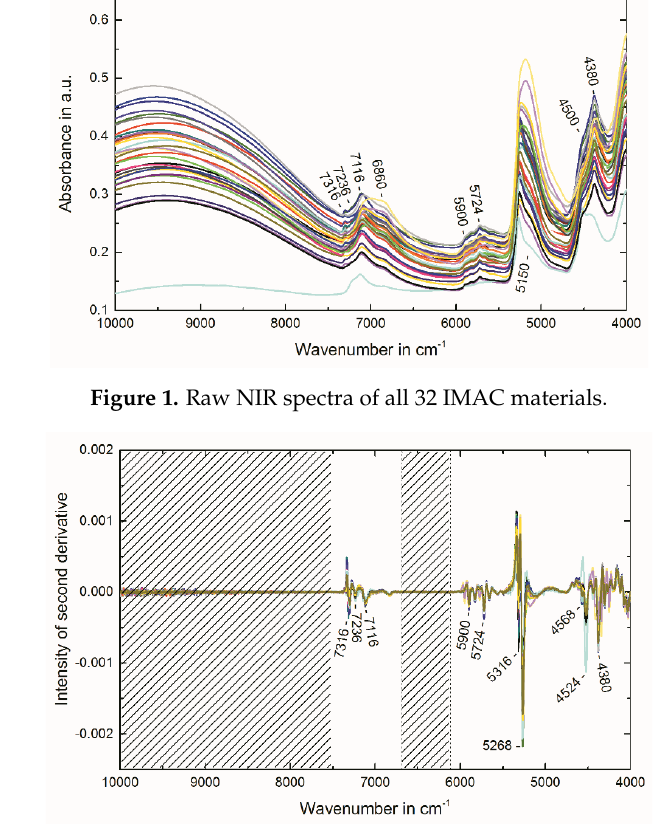
Figure 2. Pretreated NIR spectra of all 32 IMAC materials (Savitzky–Golay derivative order: 2, polynomial order: 2, 5 smoothing points).